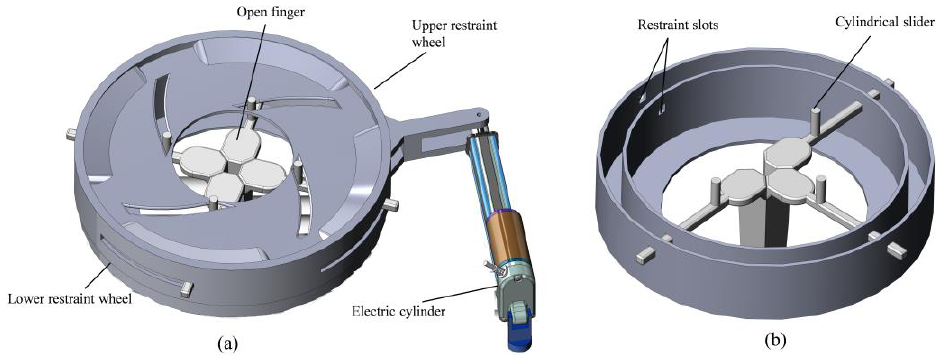
Figure 14. ( a ) Schematic diagram of the net opening mechanism; ( b ) Schematic diagram of lower restraint wheel.